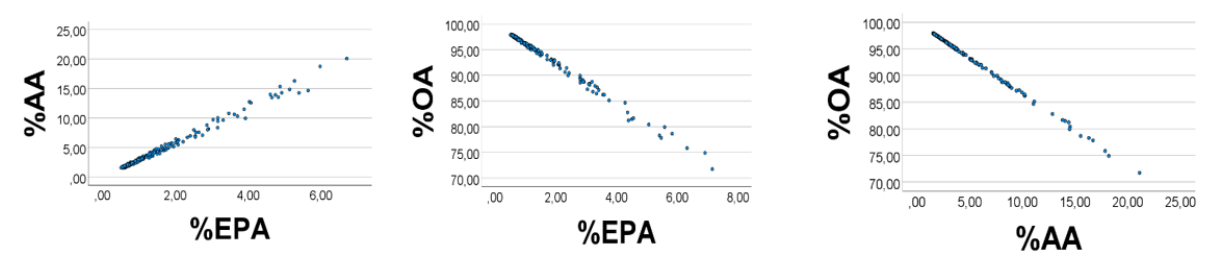
Figure 5. Effect of broadening the OA ’ range, and narrowing ranges of EPA ’ and AA ’ , upon associations between their relative amounts, in a computer experiment. S = OA ’ + EPA ’ + AA ’ . RANDOM numbers ( n = 200) were used in lieu of true values. Ranges of EPA ’ , AA ’ , and OA ’ were 0.10–0.12, 0.30–0.33, and 1–20, respectively. %EPA ’ vs. %AA ’ : rho = 0.989; %OA ’ vs. %EPA ’ (%AA ’ ): rho = − 0.994 ( − 0.999), p < 0.001 for all. Equation of the %AA ’ vs. %EPA ’ regression line was %AA ’ = 2.84 (0.02) %EPA ’ + 0.02 (0.04). Note: In the figure we have omitted the random number mark ( ‘ ) on the variables.